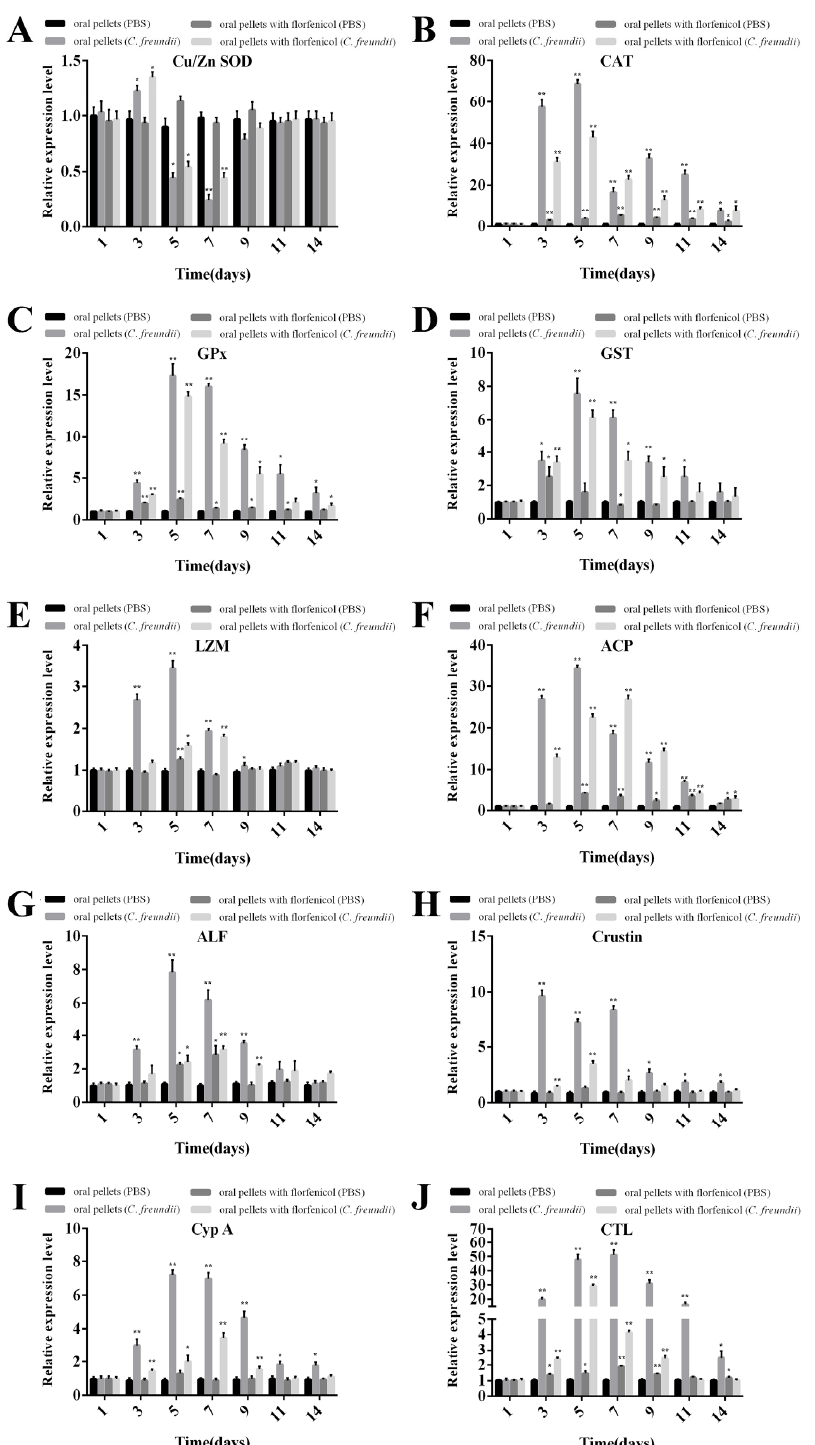
Figure 10. Analysis of immune-related gene expressions in hepatopancreas of M. rosenbergii in response to C. freundii challenge by RT-PCR at 1-, 3-, 5-, 7-, 9-, 11-, and 14-dpi. ( A ) Cu/ZnSOD, ( B ) expression levels of immune-related genes were measured by qRT-PCR, and measurement was performed in triplicate for each sample. Expression values were normalized to those of β -actin using the Livak (2 − ∆∆ CT ) method, and the expression level detected at 1 day was set as 1.0. Data are presented as mean ± SEM ( n = 3); * p < 0.05, ** p <